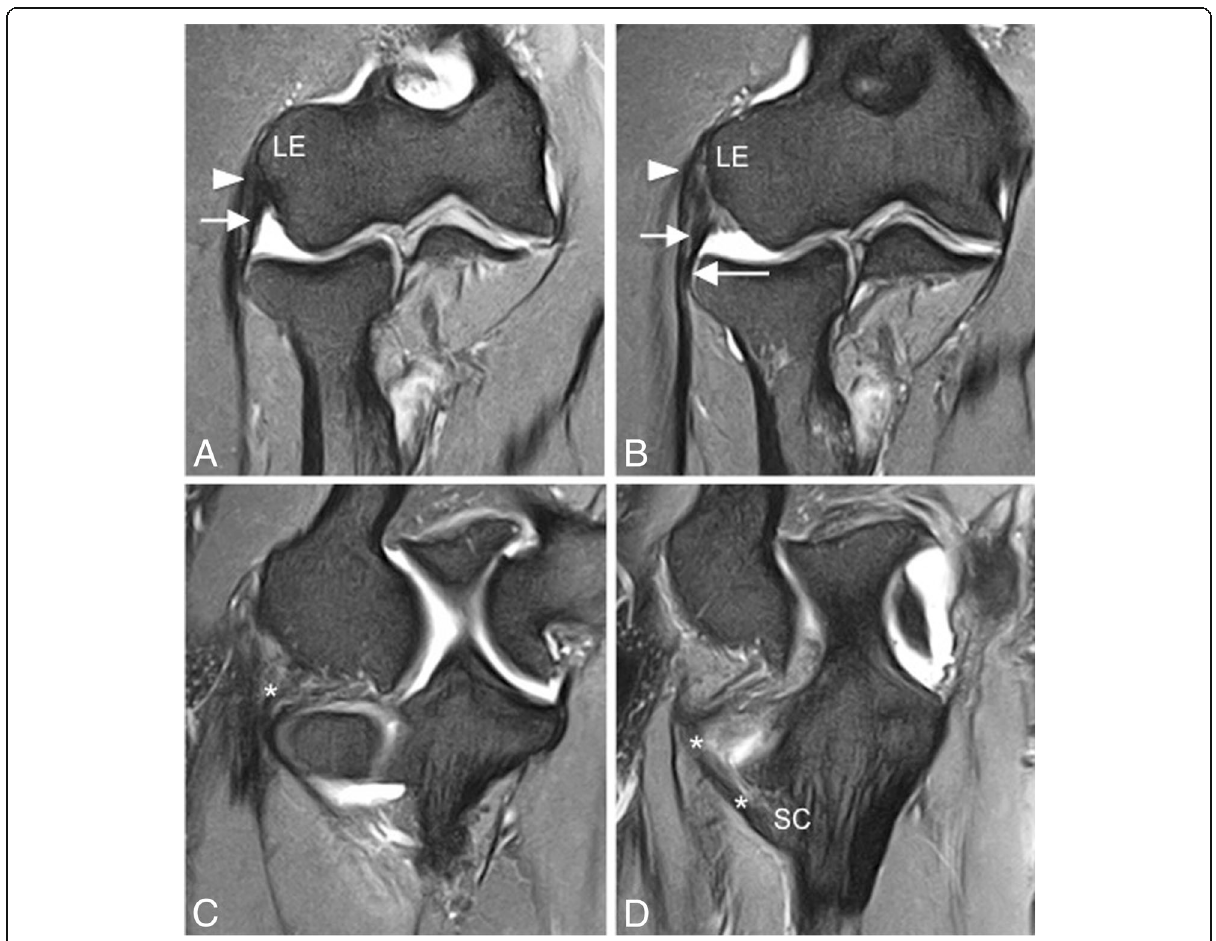
Fig. 7 Consecutive coronal FS PD-weighted MRI ( a – d ) showing the intact lateral ulnar collateral ligament (white asterisks) and radial collateral ligament (short arrows). The lateral ulnar collateral ligament wraps around the posterior aspect of the radial neck. Annular ligament (long arrow). Common extensor tendon (white arrowheads). Lateral epicondyle (LE). Supinator crest of the ulna